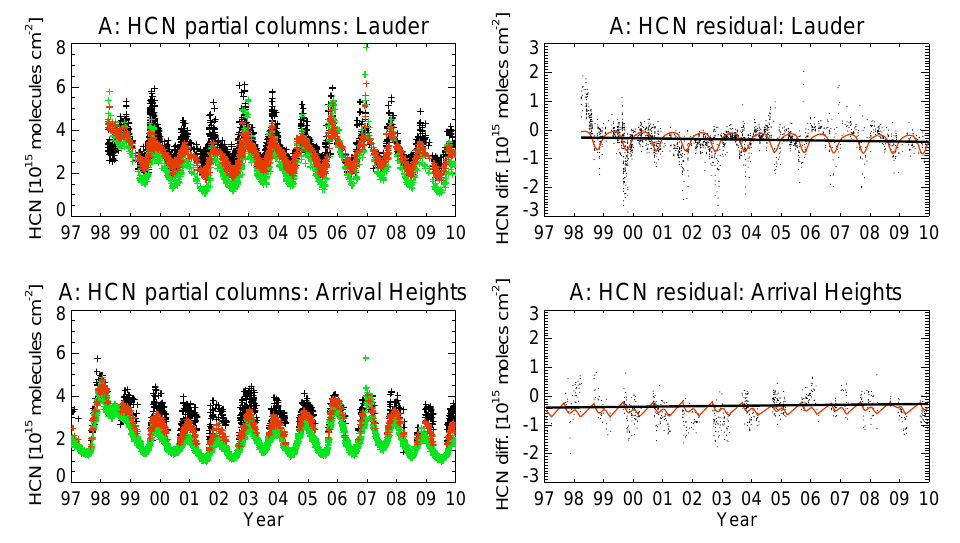
Fig. 6. Same as Fig. 4 for HCN with just simulation